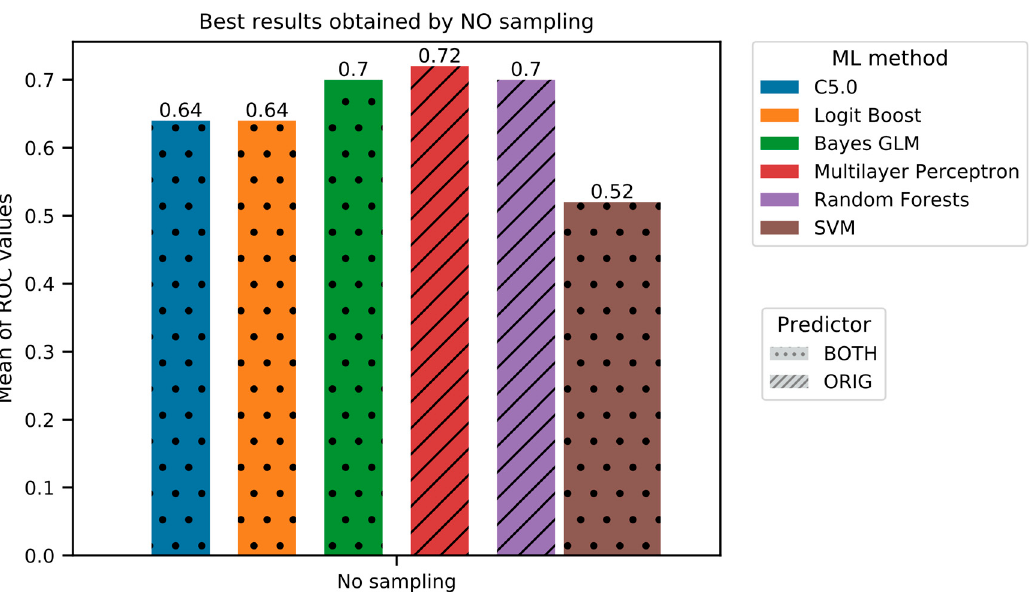
Figure 1. Highest mean accuracy values in non-sampling subset, corresponding to each ML method. Each color bar represents the different classification models. The texture of the bar represents the input predictor from which each model has been generated. The width of the bar represents the number of evaluators that annotated the dataset (3 for the thinner bars and 5 for the thicker one).